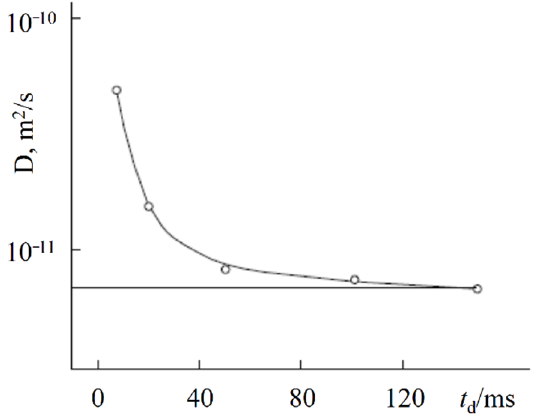
Figure 24. Average water molecule and hydrated H + counterion self-diffusion coefficient dependence on the diffusion time in the acidic form of the F-4CF membrane; relative humidity is 95%. Adapted from [24,38].